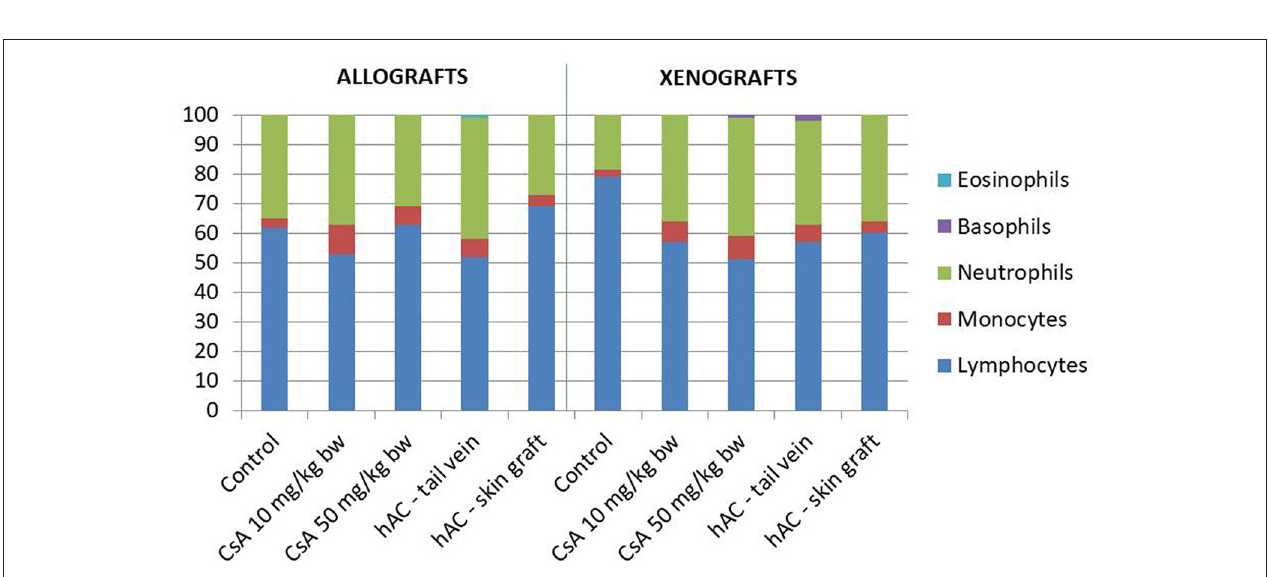
FIGURE 5 | The concentration of the mouse acute phase marker S-amyloid P (SAP) in the serum of the recipient mice in the study groups on the last day of observation for the given animal; n = 10.